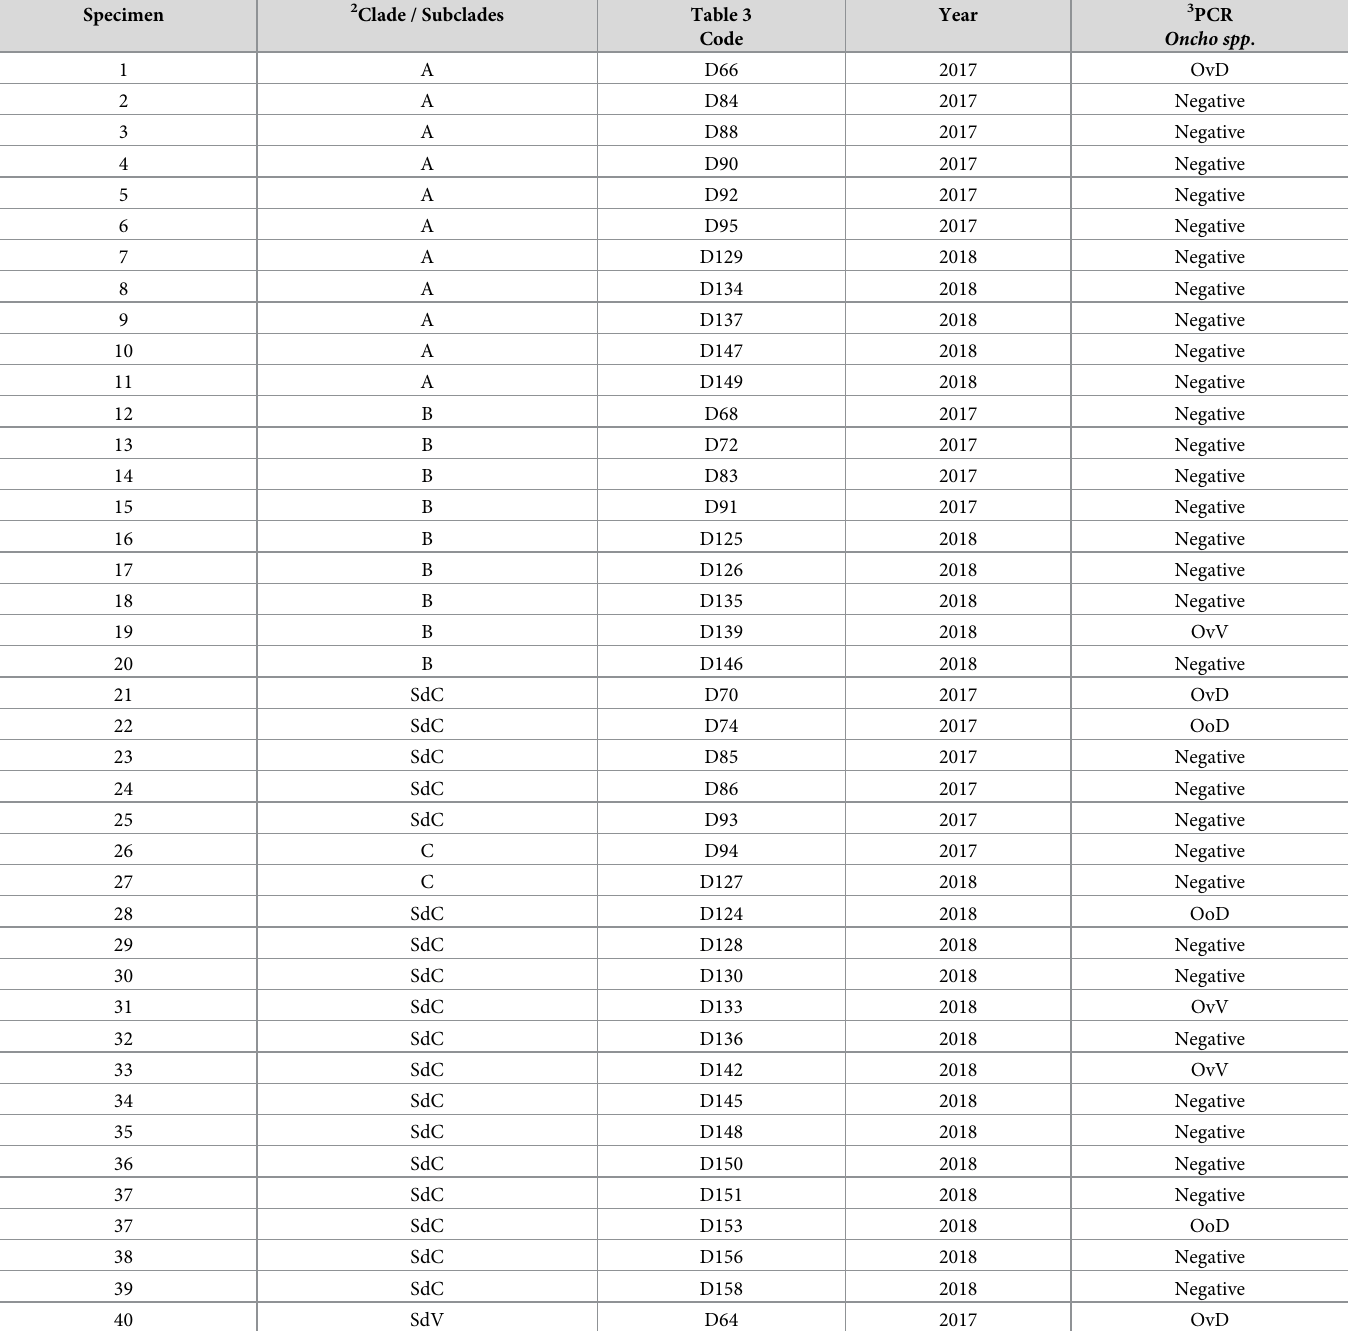
Table 3. Collection data for specimens used for DNA barcoding 1 . Specimen Table 3